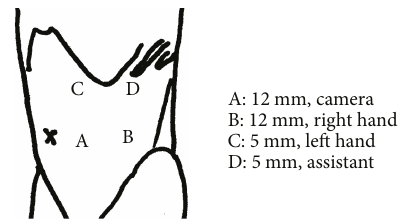
Figure 2: Laparoscopic ports in this